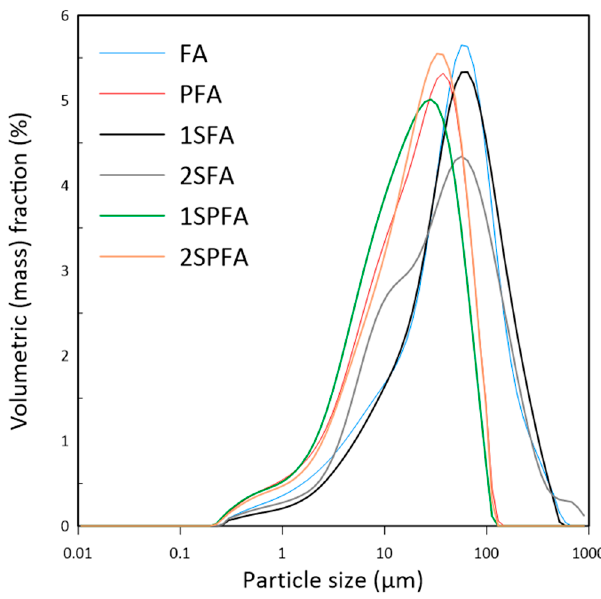
Figure 3. Particle size distribution of fillers.